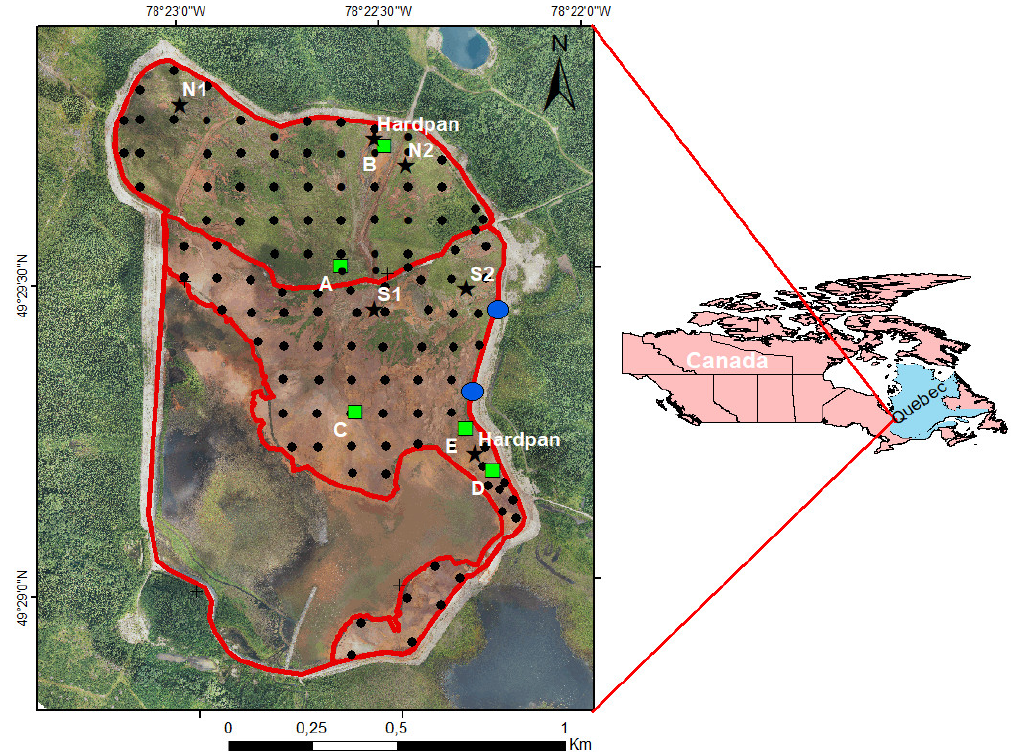
Figure 2. Map showing the sampling grid at the Joutel mine site. N1, N2, S1, and S2 refer to oxygen consumption test locations done on tailings, hardpan (north) and hardpan (south) correspond to oxygen consumption tests done on hardpan, and the green tiles correspond to samples analyzed using QEMSCAN. Red polygon corresponds to the TSF dam and blue circles correspond to the input locations of tailings.